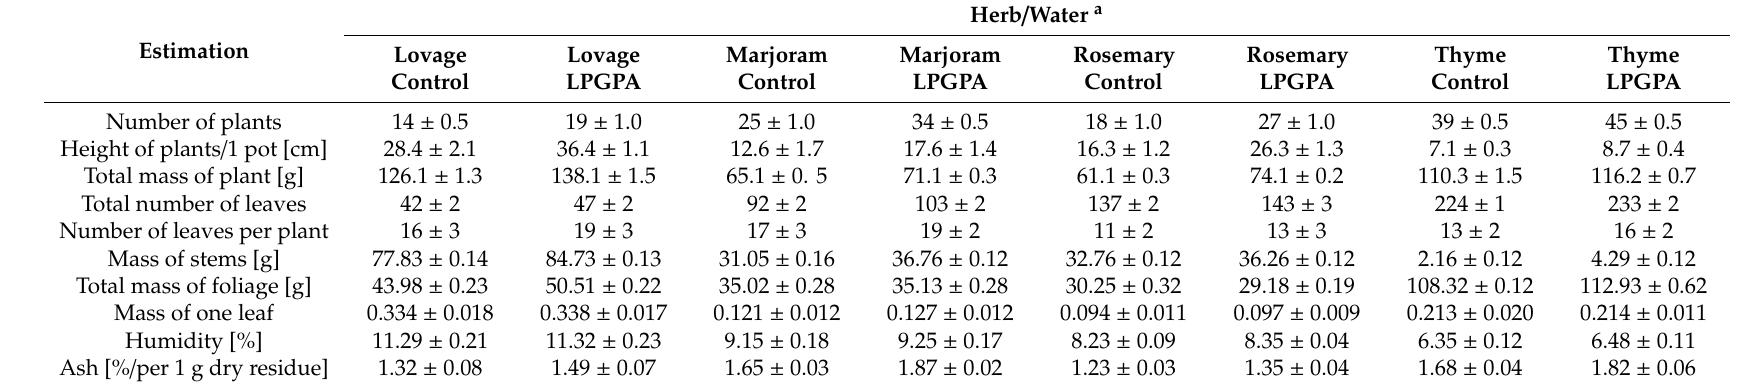
Table 1. Characteristics of the planted herbs.